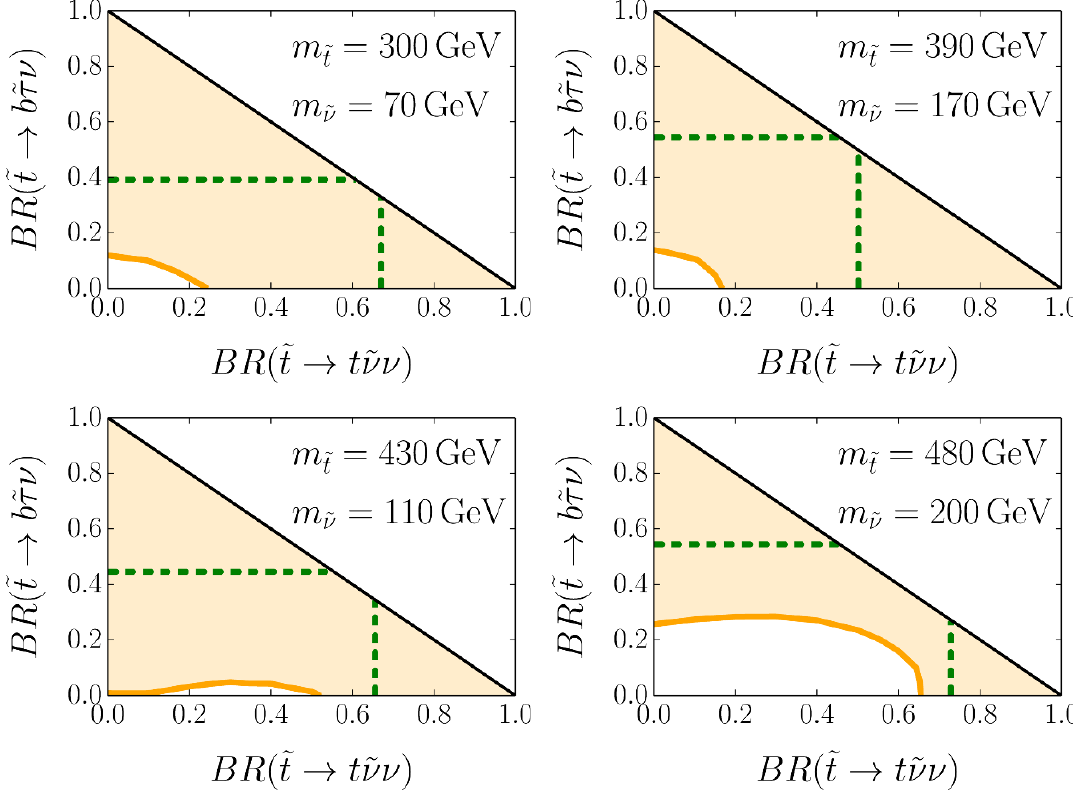
Figure 4 . Excluded regions at 95% CL in the plane of BRs for di(cid:11)erent pairs of ( m areas below (to the left of) the horizontal (vertical) green dashed lines would be allowed if only the e t ! b (cid:28)(cid:23) ( e t ! t (cid:23)(cid:23) ) mode was considered. The areas enclosed by the orange solid lines are e e excluded when all channels are combined. The areas above the diagonal black solid straight lines are forbidden by the condition of eq.